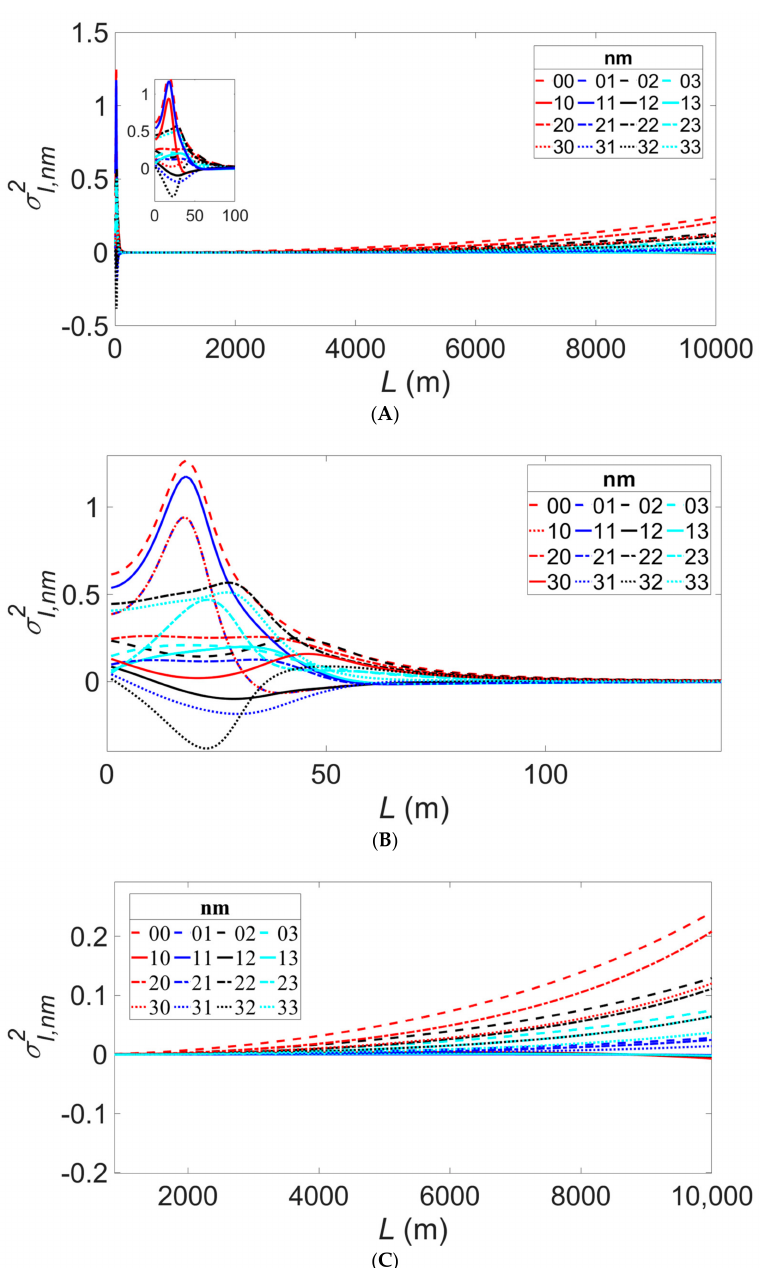
Figure 3: same parameters with Figure 1A